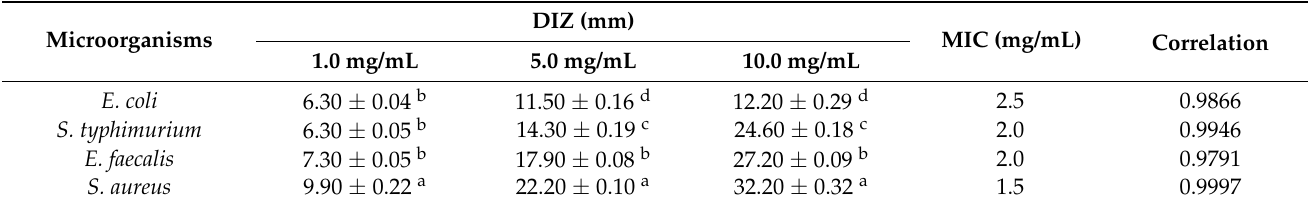
Table 4. DIZ and MIC of TCs extracted from green tea against tested